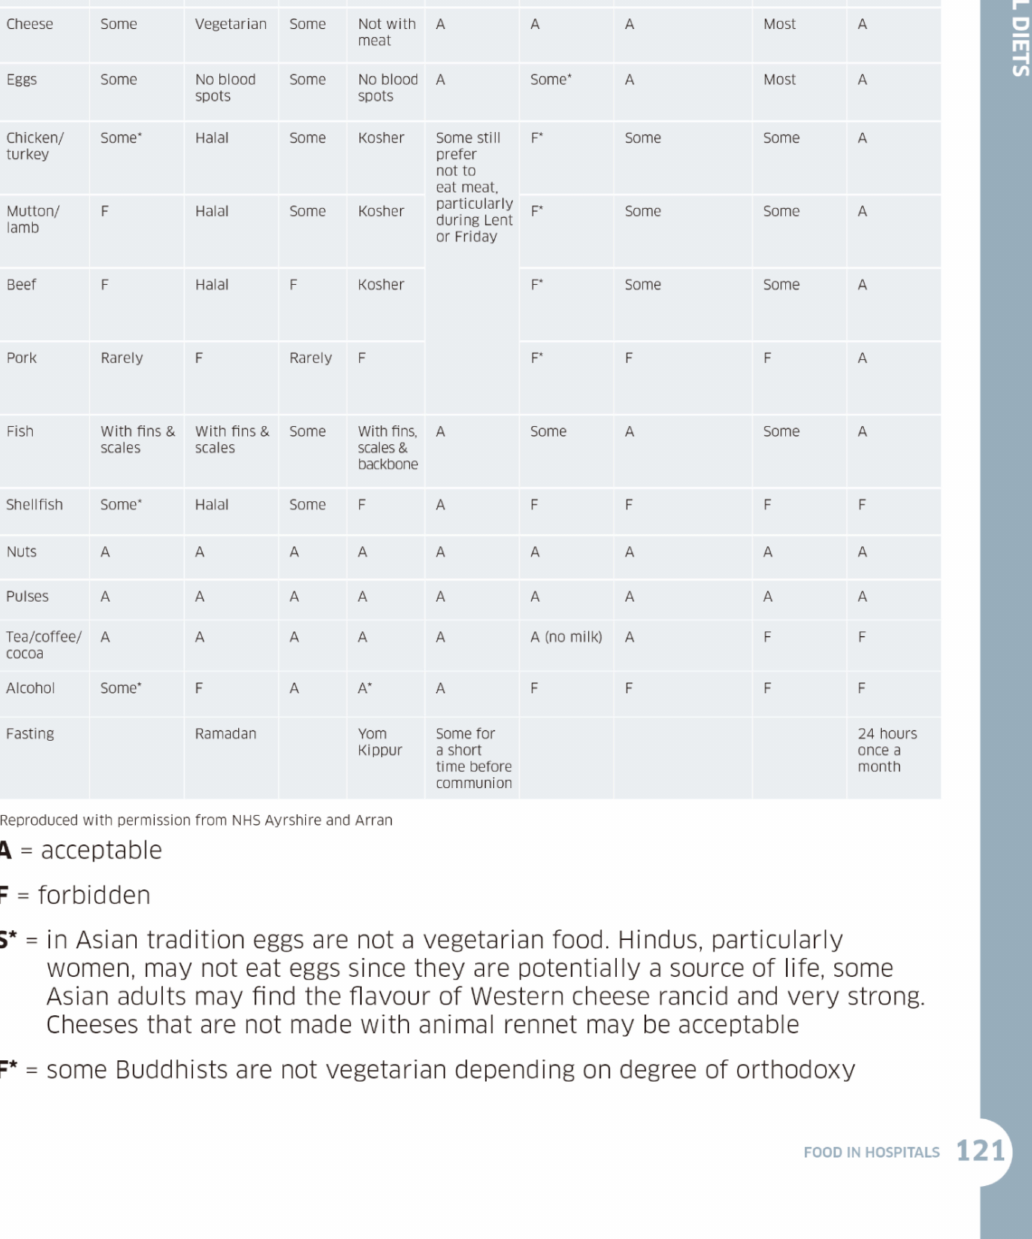
Figure 1. Food Rules of Religions (Food in Hospitals, Scottish Government